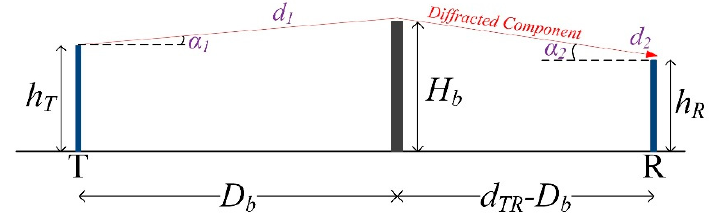
Figure 4. Basic principle of the knife-edge diffraction theory.